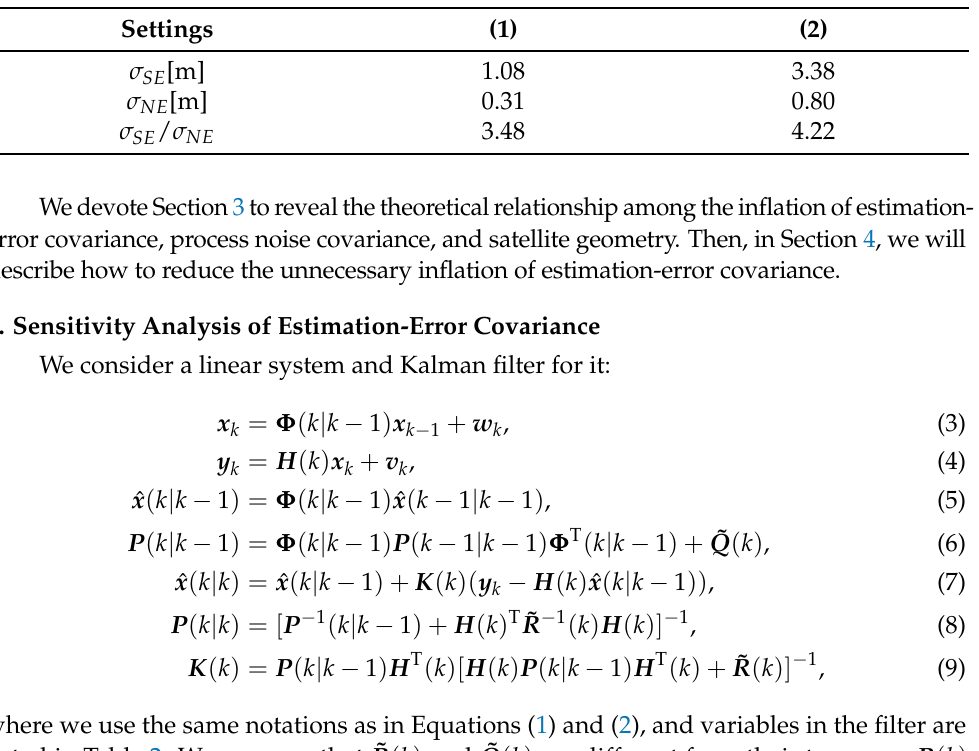
Figure 3. Estimated positions obtained by repeating Kalman filter computation 1000 times. Table 1. Standard deviations of estimate